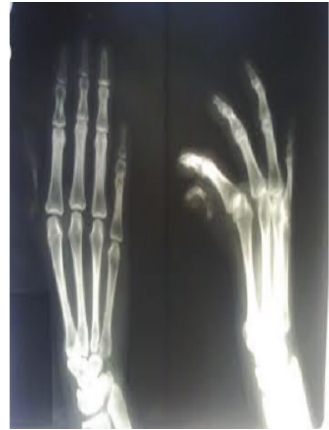
Figure 1: Rudiment thumb and little fingers with adductor defor- mity of both wrists.